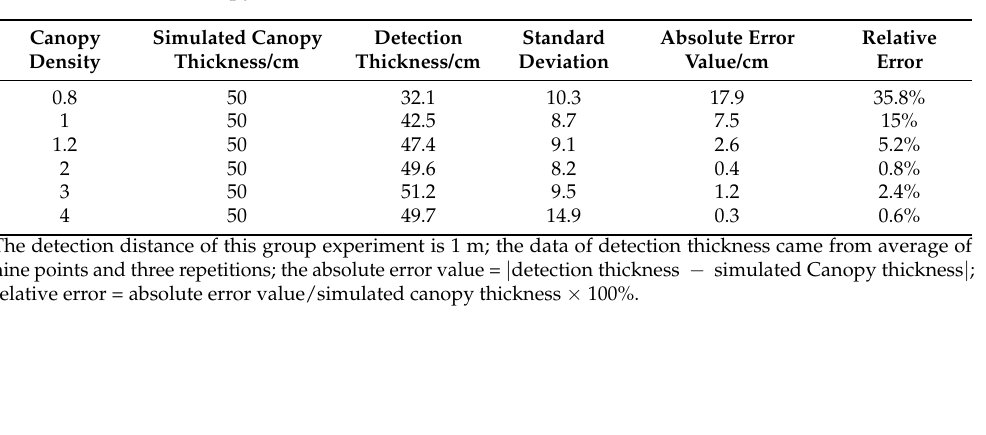
Table 3. Simulated canopy thickness detection results under different